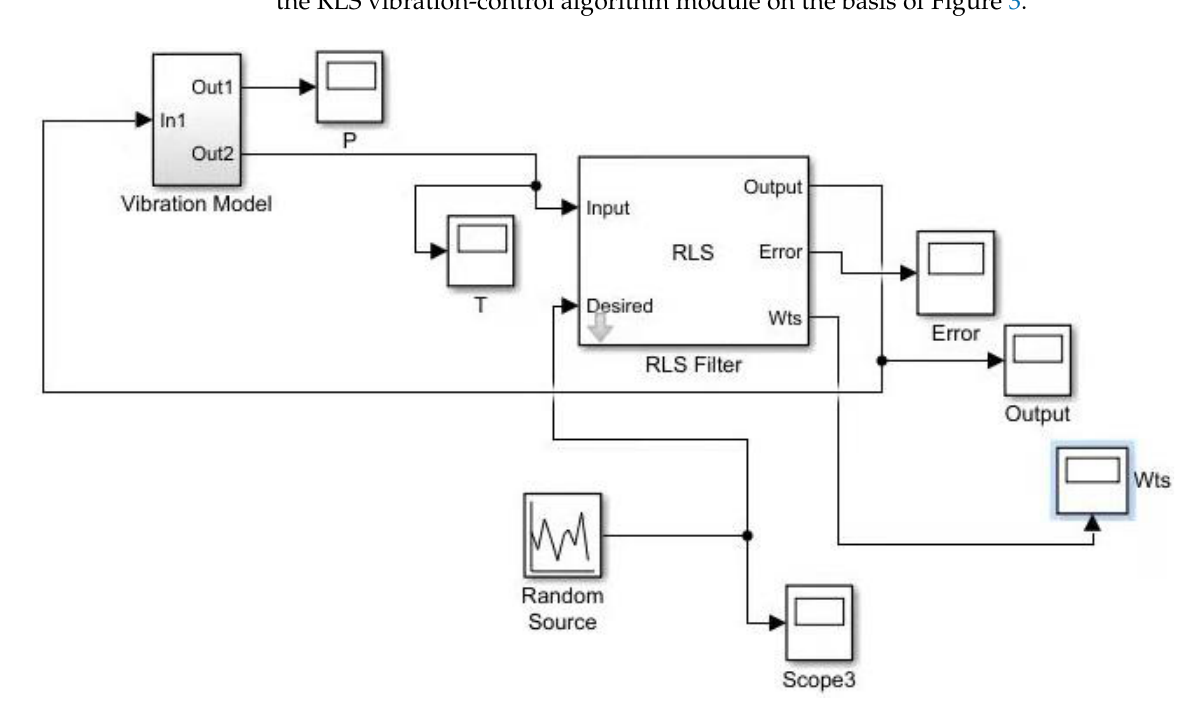
Figure 9. The dynamics Simulink model using the RLS vibration control. Based on the oscilloscope results in the dynamics Simulink model, the vertical accelerations of the swing shaft, the lower die and the frame are obtained in Figure 10. Similar to the oscilloscope results in the dynamics Simulink model using the LMS vibration control, the amplitudes of these accelerations also tend to be 0 m/s 2 . The RLS vibration control is also distinctly conducive to reducing the vibration of the COF machine.